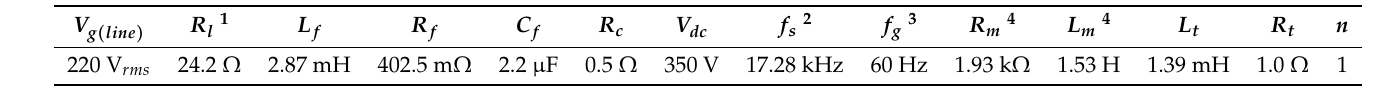
Table 1. Parameters of the prototype.